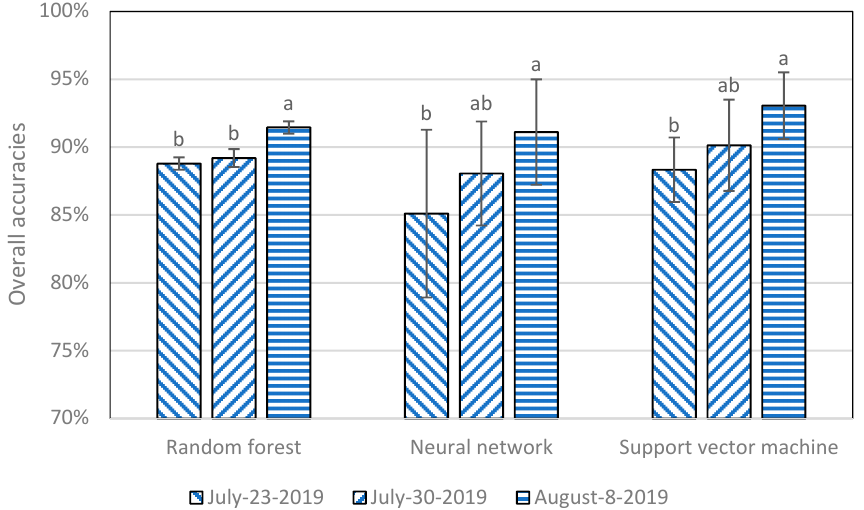
Figure 14. Accuracy comparisons of different dates datasets for different classifiers. Whiskers on bars represent two standard deviations calculated from 10 replicates. Bars with different letters are significantly different by Tukey’s test at 0.05 significance level.